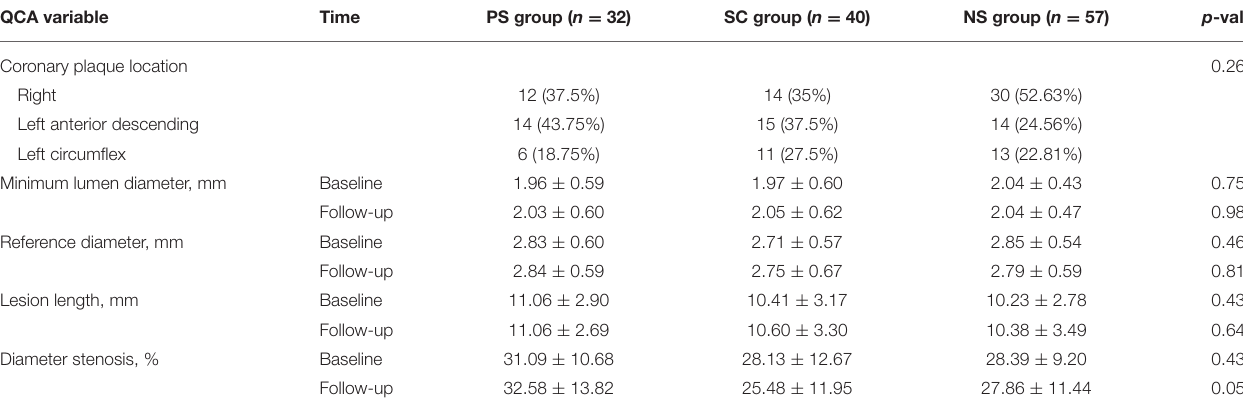
TABLE 3 | QCA data.